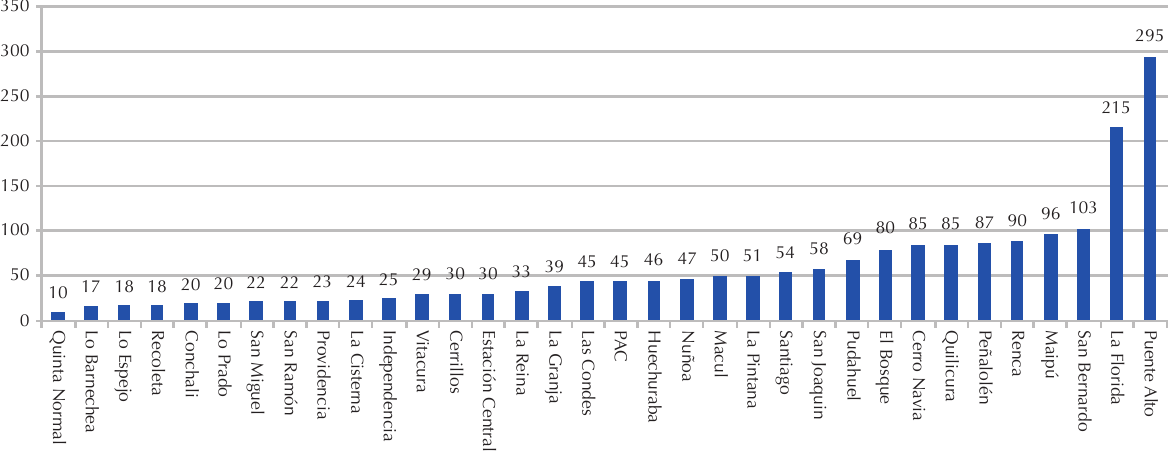
Figure 3: The 1,981 outdoor gyms in public spaces currently in operation in Santiago. Source: own elaboration